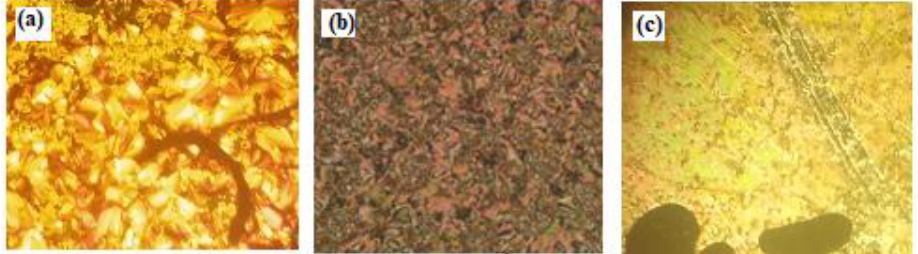
Figure 2. Effect of the alkoxy-chain length ( m ) of the azopyridine-based derivative ( Im ) on mesophase behavior of the 1:1 SMHBCs ( a ) A6 / Im ; ( b ) A8 / Im ; ( c ) A8 / Im .